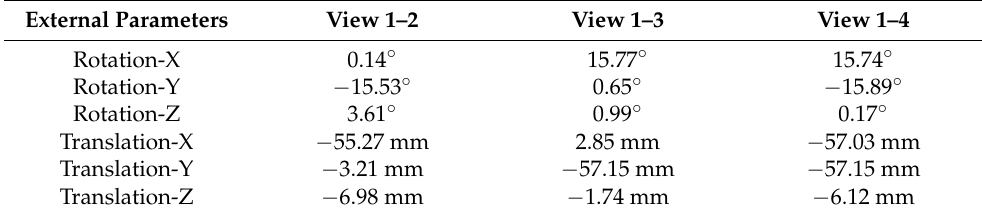
Table 2. Extrinsic parameters between the first view with other